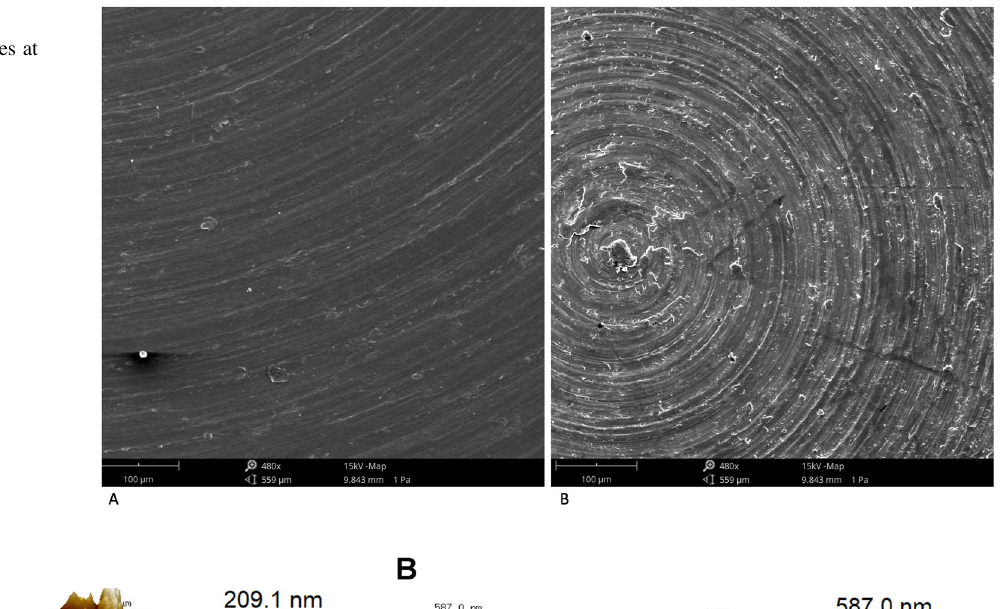
Fig. 2 Super fi cial micro- topography of PEEK samples at higher magni fi cation ( a ), compared with titanium machined ( b )